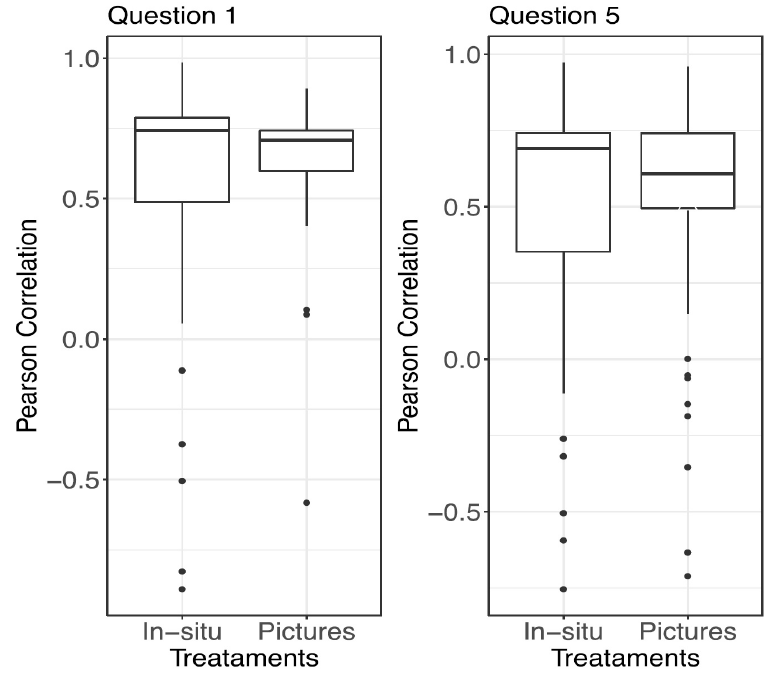
Figure 5. Boxplot comparing the Pearson coefficients of two questions between the experiments in-situ (100 people) and through pictures (87